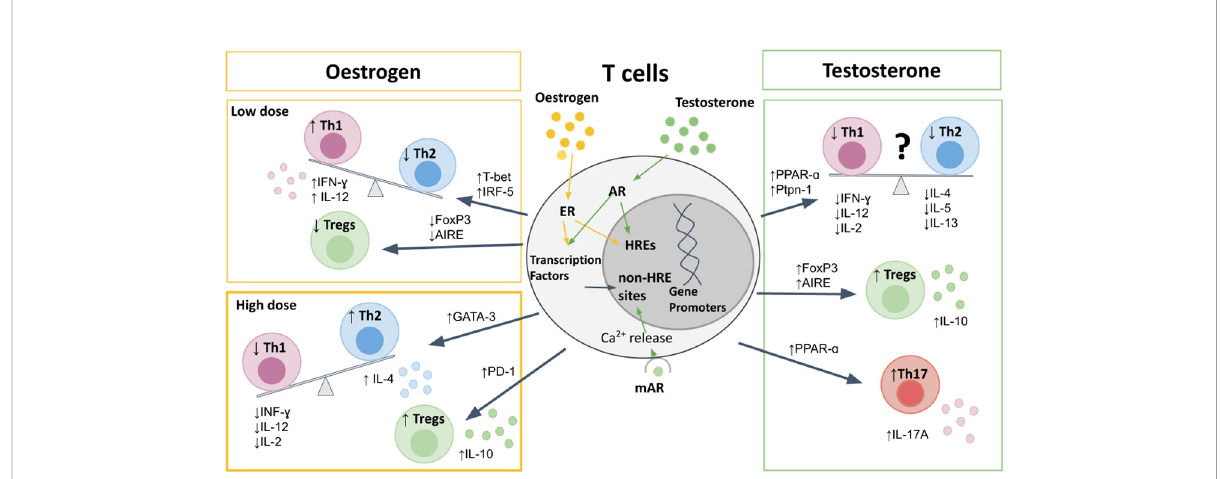
FIGURE 1 The effects of sex hormones on T cells. Sex hormones bind to nuclear receptors, leading to direct binding to HREs, or indirect effects on gene promotors through transcription factors. Oestrogen at pre-ovulatory concentrations upregulates T-bet and IRF5 to cause a Th1 shift, and downregulates AIRE and FoxP3 to reduce Tregs. High-dose estrogen during pregnancy leads to a Th2 shift, via GATA-3, and promotes Treg expression and PD-1 expression. Testosterone upregulates PPAR- a , and Ptpn-1 leading to reduced Th1 responses, but also suppresses Th2 cytokine production, and therefore the Th1/Th2 bias is less clear. Testosterone does increase Th17 production, as well as increasing expression of FoxP3 and AIRE to promote Treg differentiation and increased IL-10 production. AIRE, autoimmune regulator; AR, androgen receptor; ER, estrogen receptor; FoxP3, Forkhead-box-P3; HREs, hormone response elements; IFN, interferon; IL, interleukin; IRF, interferon regulatory factor; mAR, membrane androgen receptor; PPAR, proliferator-activated receptor; Ptpn, protein-tyrosine phosphatase; Th, T-helper; Treg, regulatory T